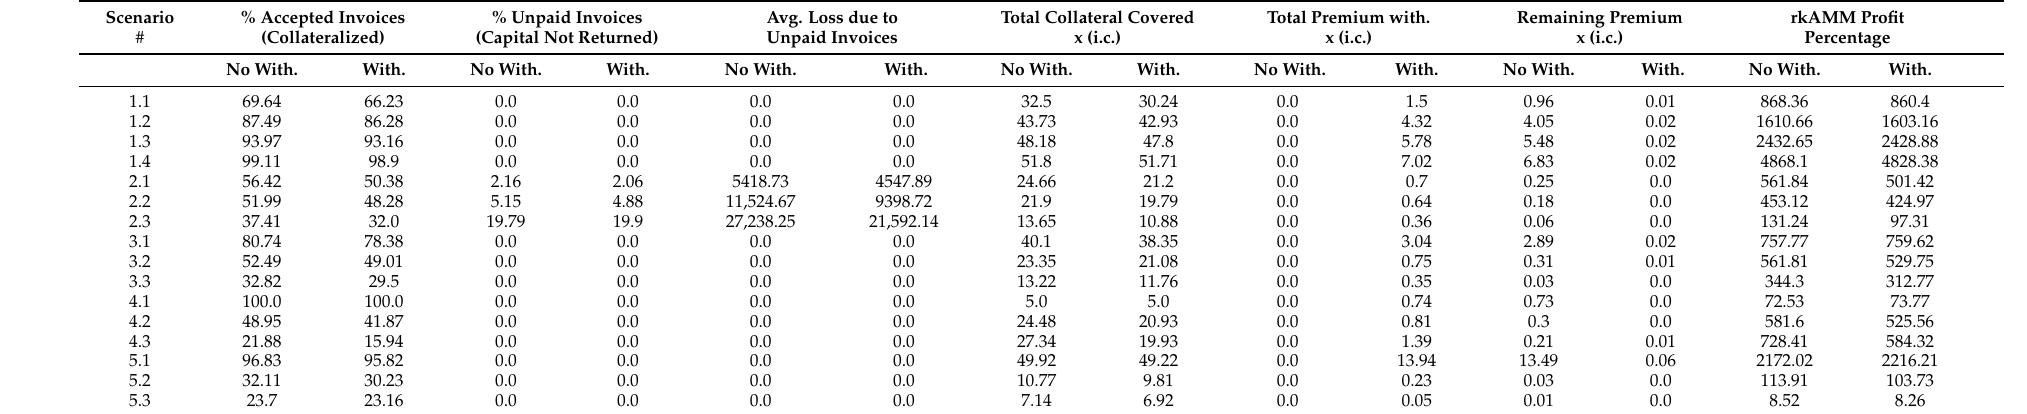
Table 11. rkAMM results. Every 30 days, 50% of the premium obtained is withdrawn.